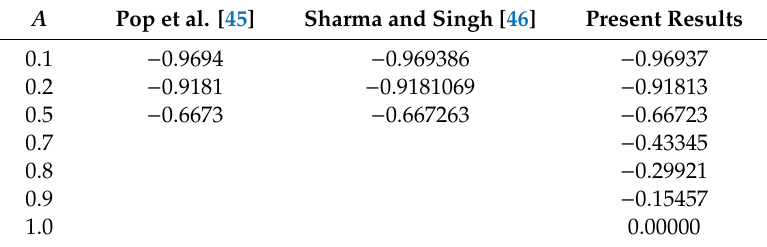
Table 5. Comparison with previous